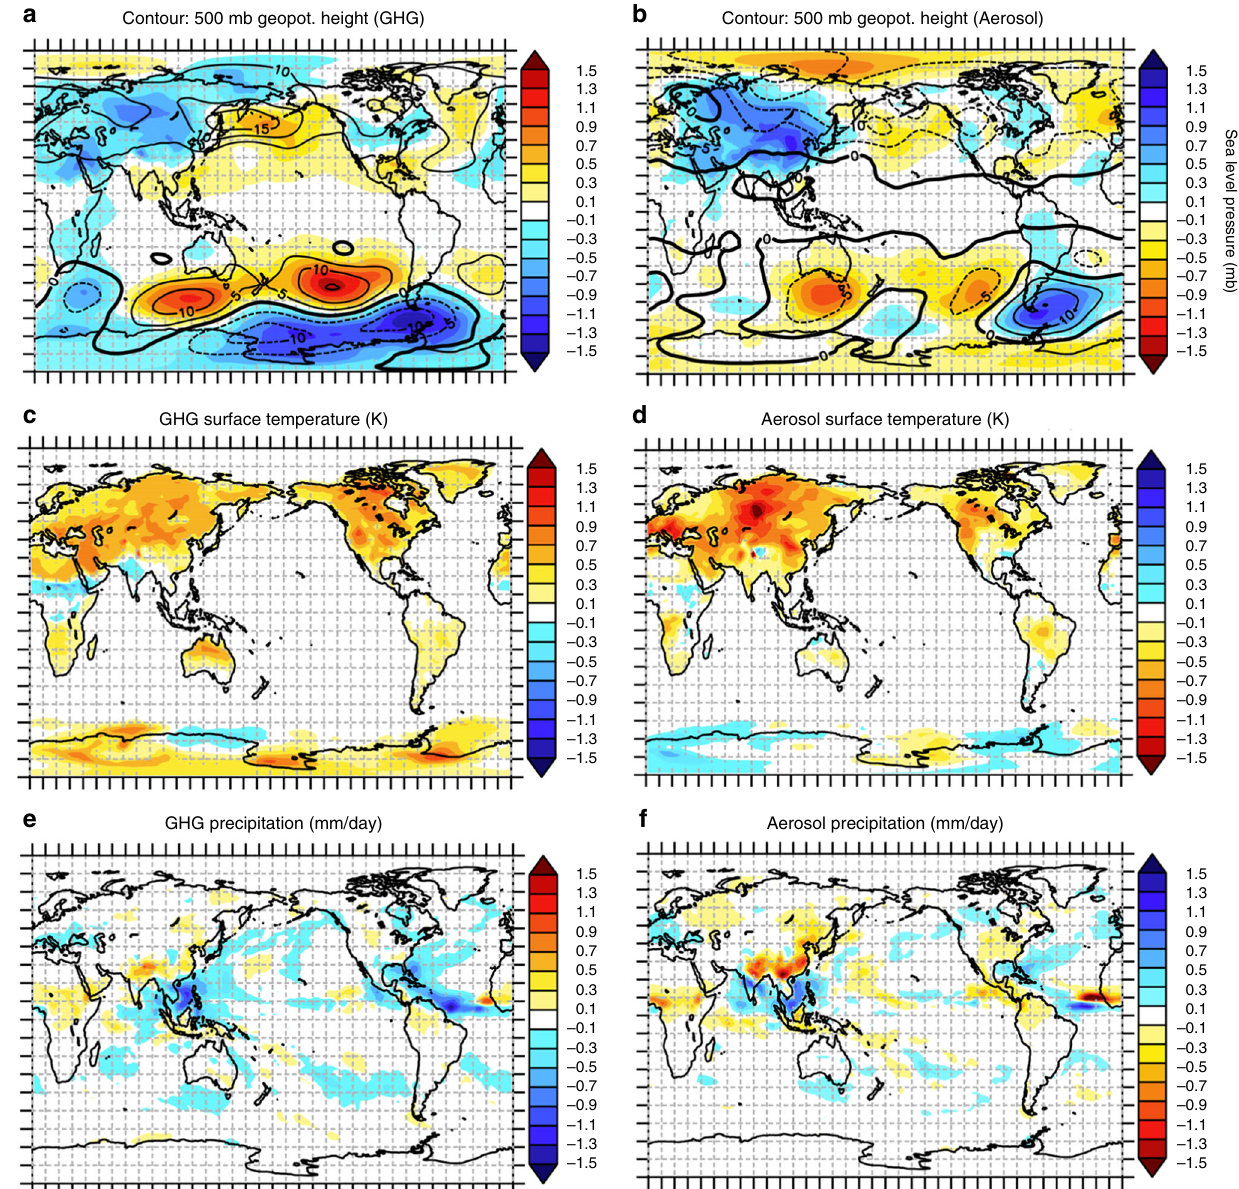
Fig. 3 Spatially similar circulation changes. June – July – August (JJA)-mean perturbations due to a , c , e greenhouse gases (GHGs) and b , d , f aerosols in a , b 500 mb geopotential height (contour interval, 5 m) and sea level pressure, c , d surface temperature and e , f precipitation. Gridded regions are not statistically signi fi cant at the 95% con fi dence level via t -test. Note that the color palette for aerosol signals ( b , d , f ) is reversed relative to that for GHG signals ( a , c , e ). See Supplementary Fig. 2 for December – January – February-mean